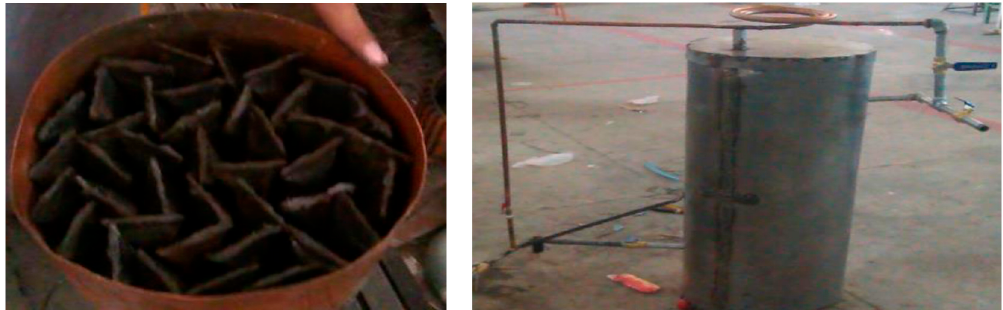
Figure 9. Fabrication of the storage tank.